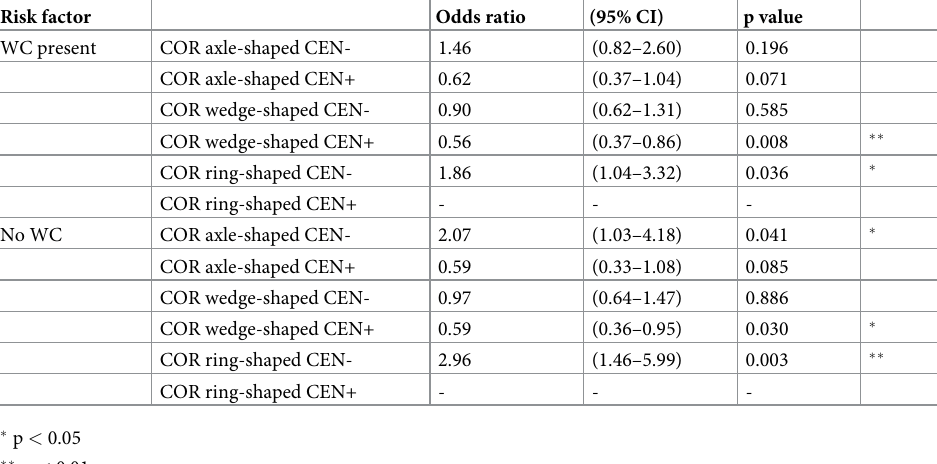
Table 6. COR (axle-shaped, wedge-shaped, and ring-shaped) risk of the high cumulative ocular UV exposure (COUV) group compared with the low COUV group (all adjusted for age, sex, axial length, and